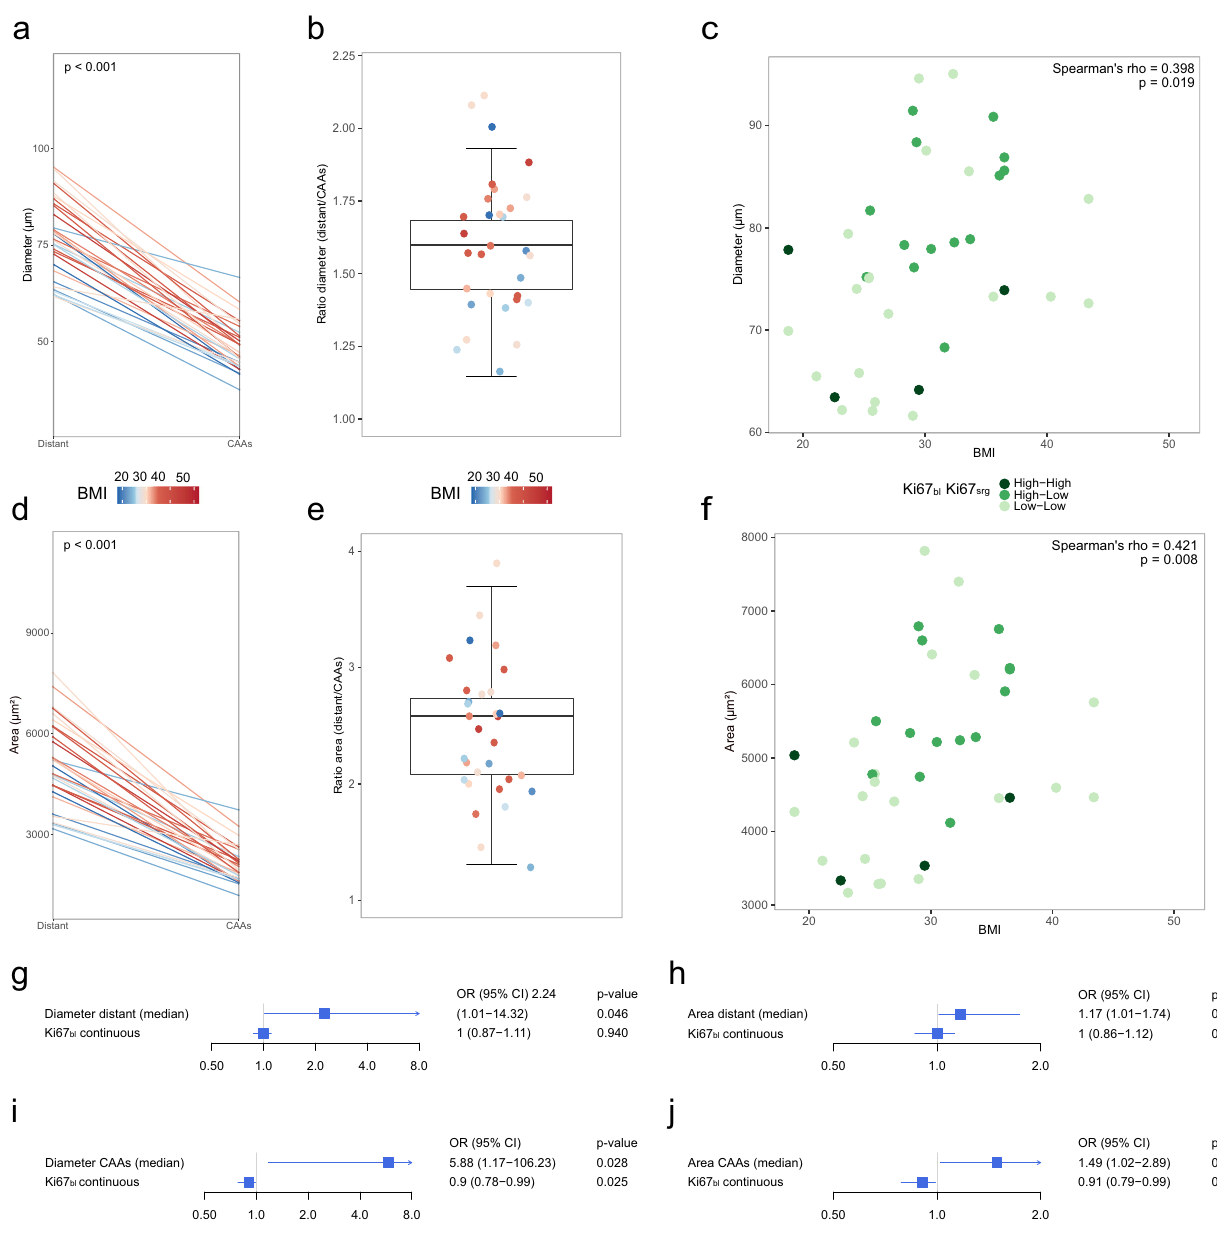
Fig. 3 Adipocyte size and associations with BMI and anti-proliferative response. a , d Parallel plots show the variation of adipocyte diameter and area between distant and CAAs. b , e Box plots show the distribution of the adipocyte diameter and area ratio (distant / CAAs). Each line and each dot corresponds to a patient and is colored according to ascending BMI. Reported P -values are from paired Wilcoxon tests. Box plots represent the median (bold line), interquartile range (rectangle), and the lower and upper whiskers (the two lines outside the box). c , f Correlation between BMI and distant adipocytes diameter (c) and area (d) . Spearman ’ s rho and corresponding P-values are reported on the top-right corner of the plots. The color indicates the Ki67 bl -Ki67 srg groups. Low – low = Ki67 bl and Ki67 srg < 14%. High – low = Ki67 bl ≥ 14% and Ki67 srg < 14%. High – high = Ki67 bl and Ki67 srg ≥ 14%. g – j Multivariable logistic models adjusted for continuous Ki67 bl investigating the association of adipocyte size and the anti-proliferative response: considering distant (g , h) or CAAs i , j and diameter (g , i) or area (h , j) . All reported P -values are from Wald tests. BMI body mass index, CAAs cancer-associated adipocytes, CI con fi dence interval, Ki67 bl Ki67 baseline, Ki67 srg Ki67 surgery, OR odds Our study sheds light on part of the system but the biological by the Ki67 index, might be greater in those patients with larger adipocytes and higher aromatase activity as compared to patients meaning through which anti-proliferative response might be positively in fl uenced by BMI and adipocyte size remains to be fully with low BMI. Hence, the aromatase inhibition might lead to a elucidated. greater suppression of the mitogenic effect re fl ected by the Ki67 In this study, we also explored the size of mammary adipocytes reduction in those patients having high BMI and/or larger in the two most prevalent histological subtypes of BC (ILC vs NST). adipocytes. We acknowledge the complexity of the biological A previous study described a different expression pattern of lipid context located at the carrefour between increased adiposity, metabolism proteins between these BC histological subtypes, adipose tissue dysfunction, breast cancer and treatment response.